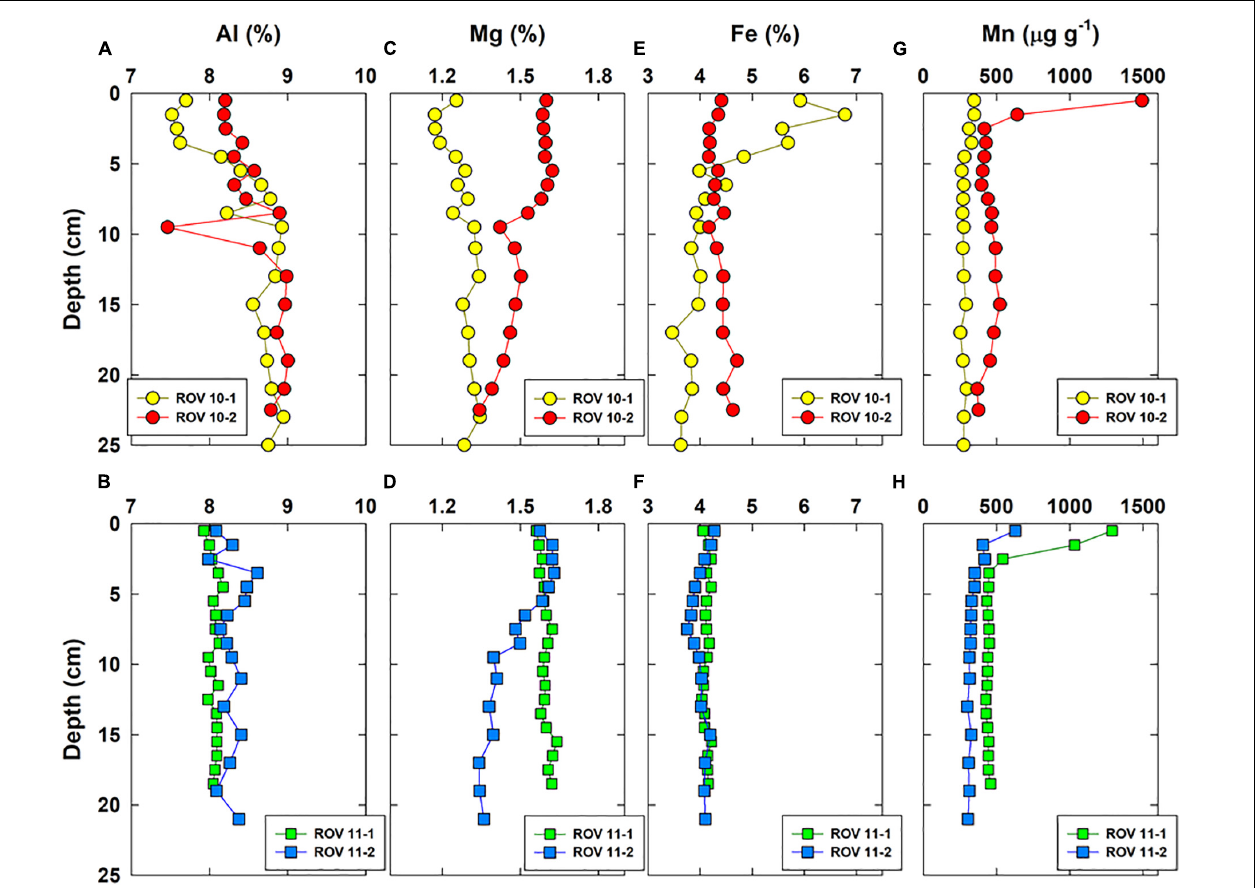
FIGURE 3 | Vertical concentration profiles of Al (A,B) , Mg (C,D) , Fe (E,F) , and Mn (G,H) in bulk sediments of the four cores collected from the southern Okinawa